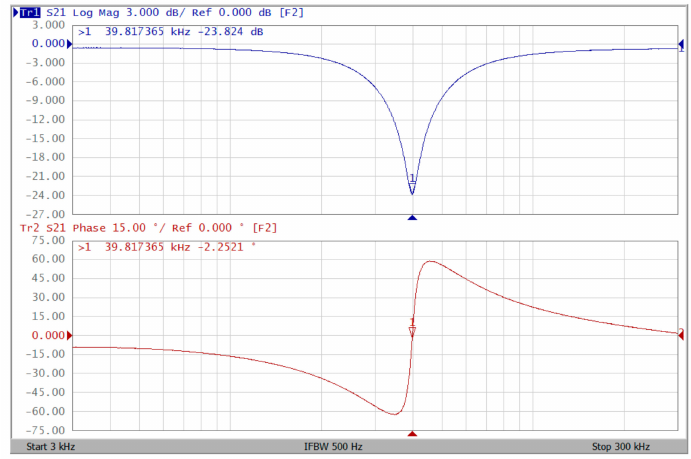
Figure 19. Measured gain and phase responses at V o2 when V i1 = V in and V i2 = 0.